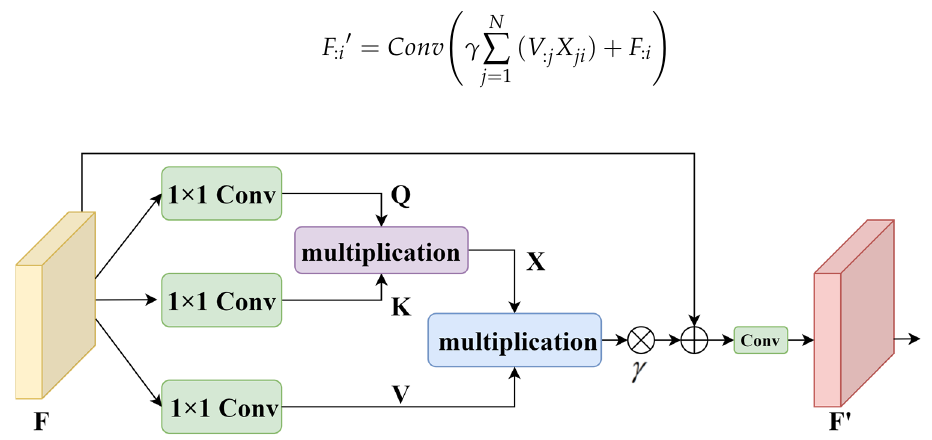
Figure 5. Object positioning module structure.